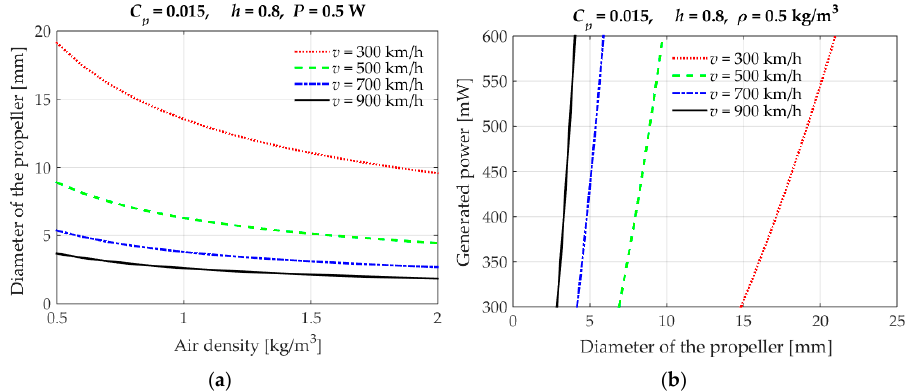
Figure 31. Diameter of the propeller vs. air density ( a ) and generated power vs. propeller diameter ( b ) for different aircraft velocities.